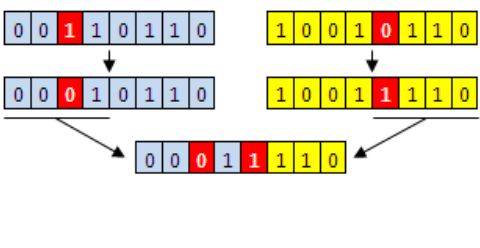
Figure 1. Mutation and crossover operations are shown on binary strings of 8 bits length. Red bits show mutation operation of alternating bits and last line shows the child individual formed by crossover operation of merging parts of parent